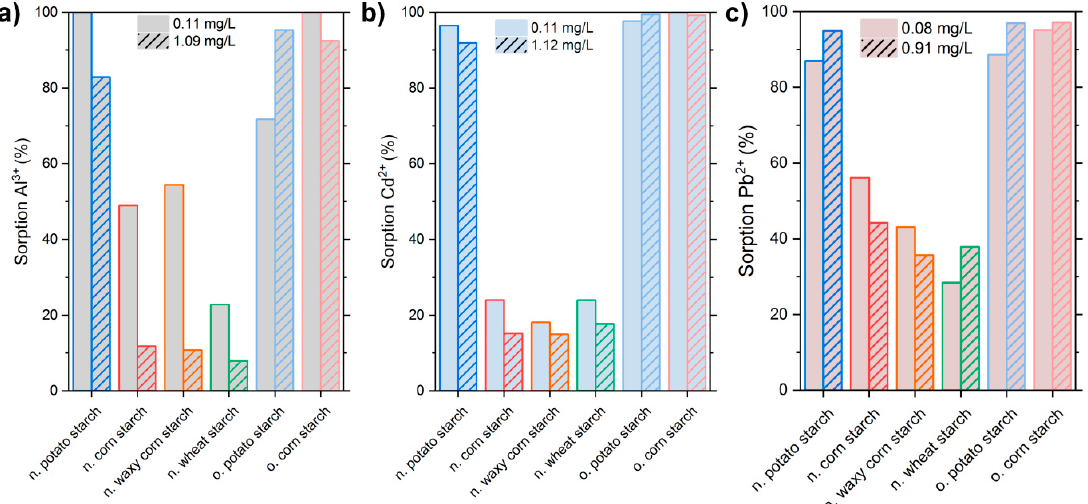
Figure 8. Screening experiments with Al 3+ , Pb 2+ , and Cd 2+ with the percentage sorption of ( a ) aluminum from Al 2 (SO 4 ) 3 adsorption experiments with an initial concentration of aluminum ions of 0.11 mg/L (solid) and 1.09 mg/L (striped); ( b ) cadmium from CdSO 4 adsorption experiments with an initial concentration of cadmium ions of 0.11 mg/L (solid) and 1.12 mg/L (striped); ( c ) lead from PbSO 4 adsorption experiments with an initial concentration of lead ions of 0.08 mg/L (solid) and 0.91 mg/L (striped) on native potato starch (blue), native corn starch (red), native waxy corn starch (orange), native wheat starch (green), oxidized potato starch (light blue), and oxidized corn starch (pink). The corresponding pH values for the sorption experiments are shown in Figures S12–S14. The corresponding adsorption of sulfate ions is shown in Figure S15, whereby most of the S-concentrations were below the limit of detection for S.